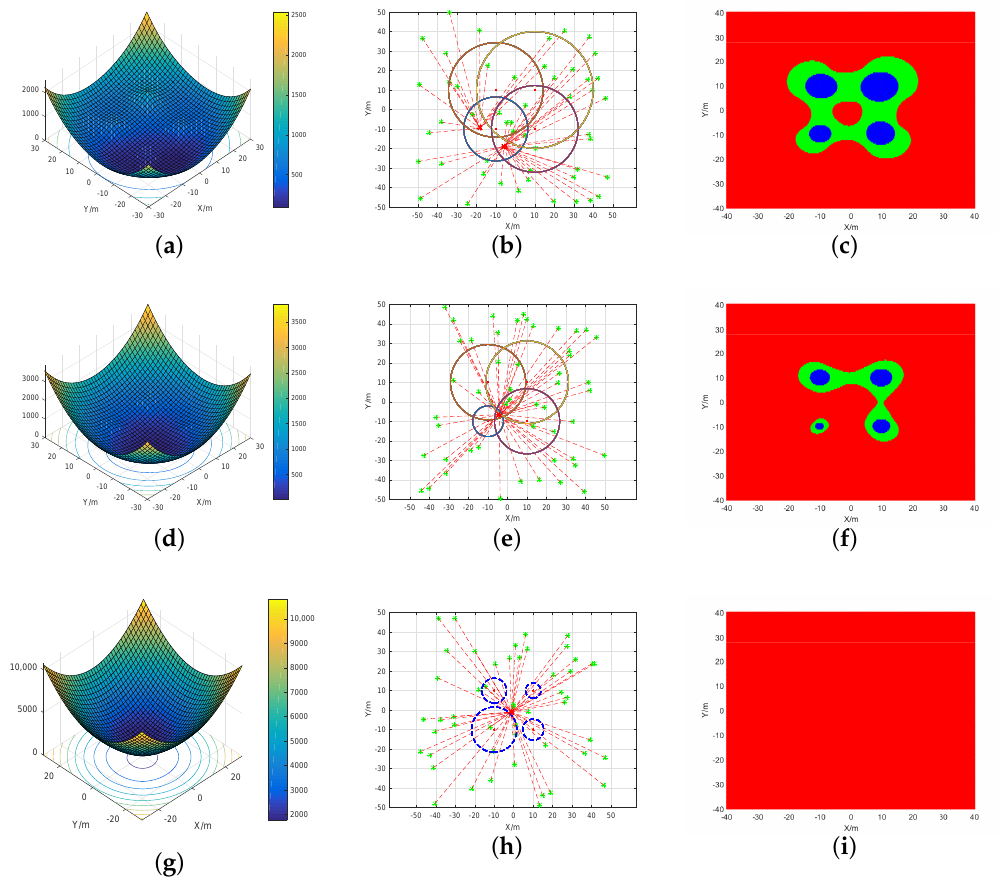
Figure 2. The graphs related to F s of one target in the noncooperative scenario. Above, Graphs ( a , d , g ) are the images of F s in each scene; Graphs ( b , e , h ) are the results of the Gauss–Newton iteration algorithm when different initial values were selected; Graphs ( c , f , i ) represent the semipositive definite distribution of Hessian matrix J in the two-dimensional